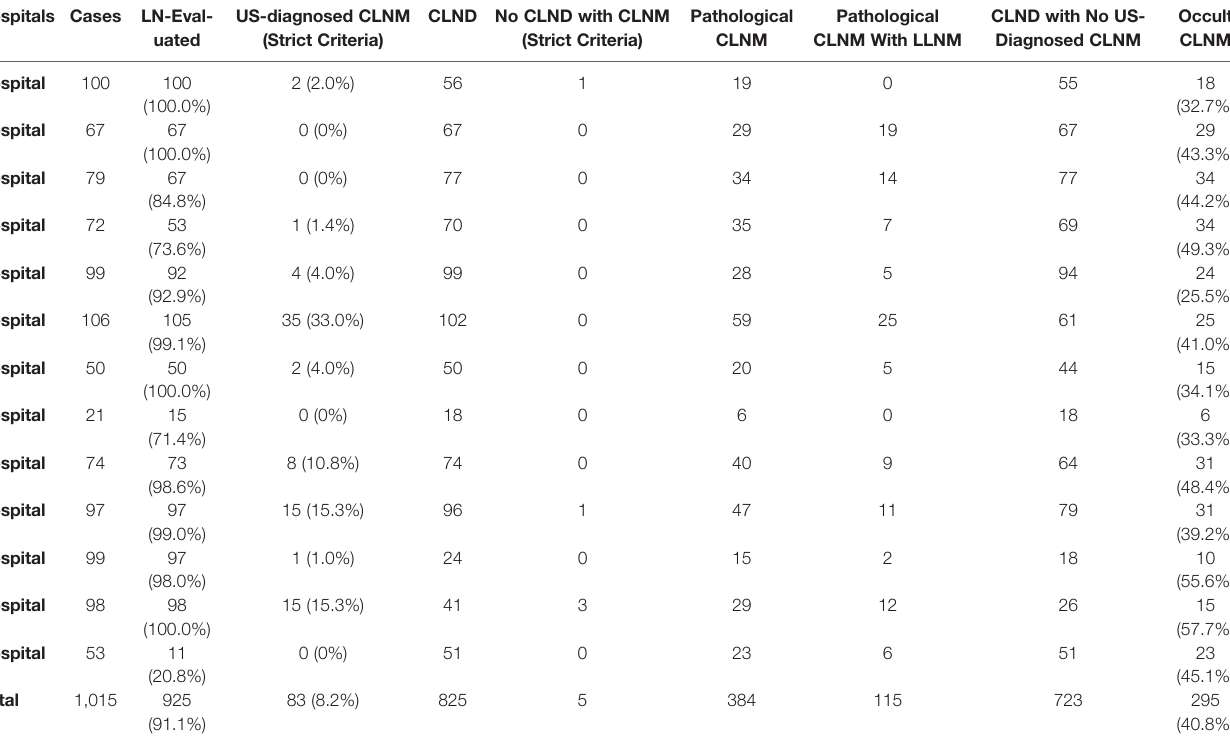
TABLE 1 | The basic situation of preoperative US evaluation in13 Grade-A tertiary hospitals among